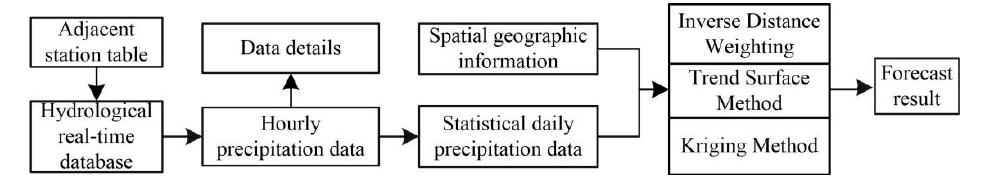
Figure 8. Flow chart of spatial data quality control.